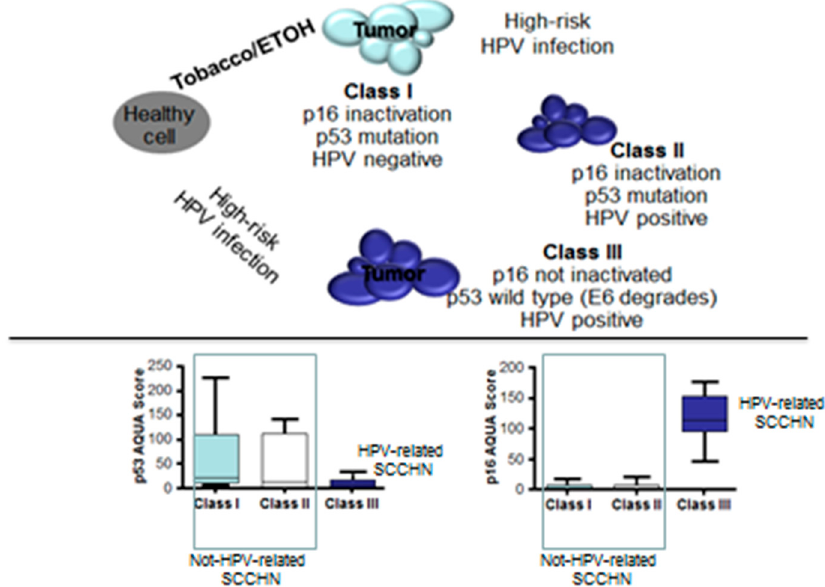
Figure 2. Proposed model for head and neck squamous cell carcinomas (HNSCC) carcinogenesis. Not all the human papillomavirus (HPV)-positive HNSCCs are also HPV-related. Both HPV-negative and HPV-positive but not HPV-related HSNCC (Class I and II, respectively) are characterized by INK-4 (the gene encoding for P16) and TP53 mutations which allow for a high expression of P53 and a down-regulation of P16 on the immunohistochemical assay. On the other hand, HPV-related HSNCC (Class III) show reverse features. 33. Source: Weinberger PM et al., J Clin Oncol. 2006 , 24 , 736–747 [33]. ETOH: alcohol; SCCHN: squamous cell carcinoma of the head and